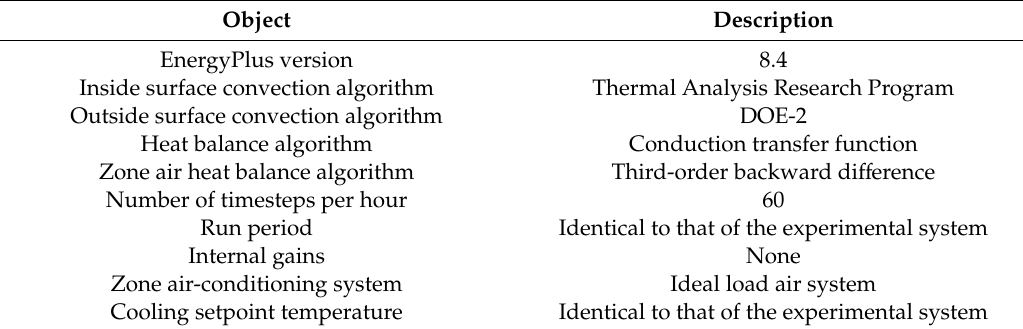
Table 4. EnergyPlus simulation